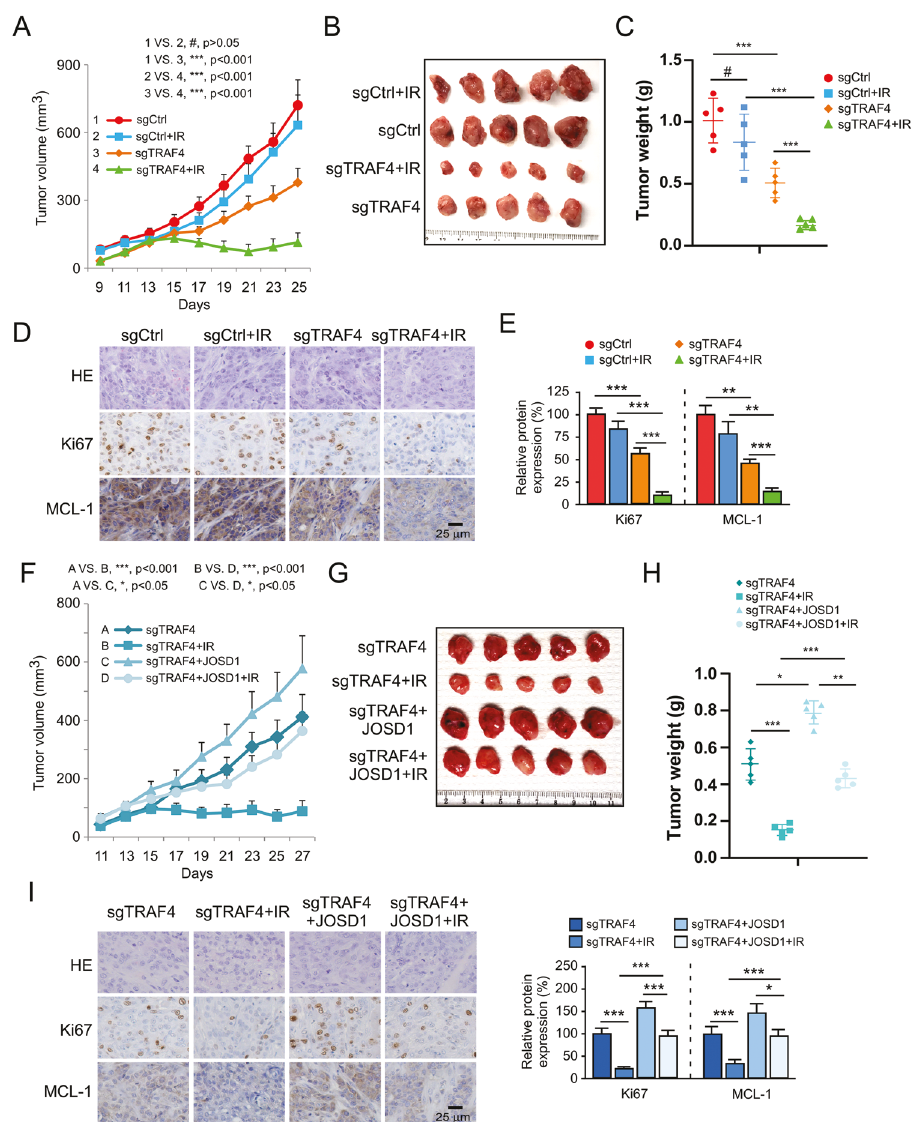
Fig. 6 TRAF4 knockout overcomes radioresistance in vivo. A – E TRAF4 knockout sensitizes OSCC cells to radiotherapy. Xenograft tumors derived from TRAF4 knockout CAL27R cells were treated with/without IR (2 Gy) for 25 days; n = 5 mice per group. Tumor growth curves ( A ), tumor mass images ( B ), and tumor weight ( C ) were recorded. Tumor sections were subjected to IHC staining of Ki67 and MCL-1 ( D ), and quali fi cation analysis of Ki67 and MCL-1 protein expression ( E ). Scale bar, 25 μ m. F – I JOSD1 introduction into TRAF4 knockout CAL27R cells rescues tumorigenesis under IR treatment. Xenograft tumors derived from TRAF4 knockout and ectopic expression JOSD1 CAL27R cells were treated with/without IR (2 Gy) for 27 days; n = 5 mice per group. Tumor growth curves ( F ), tumor mass images ( G ), and tumor weight ( H ) were recorded. Tumor sections were subjected to IHC staining of Ki67 and MCL-1 (I, left), and quali fi cation analysis of Ki67 and MCL-1 protein expression (I, right). Scale bar, 25 μ m. All data are means ± s.e.m. * p < 0.05, ** p < 0.01, *** p < 0.001, a signi fi cant difference between groups as depletion of RPL36A sensitized OSCC cells to DNA damage and promoted G 2 /M cell cycle arrest to upregulate IR-induced apoptosis, which led to increased radiosensitivity in OSCC cells [23]. MicroRNA-125b was reported to be downregulated in OSCC cells, and exhibited an antitumor effect by reducing cell proliferation and enhancing radiosensitivity through the regula- tion of intercellular adhesion molecule-2 signaling [36]. There- fore, further studies on biomarkers and the molecular pathways that are involved in radiation resistance is of great importance to better understand radioresistance characteristics and to formu- late effective treatment strategies to improve the overall survival indicating that intrinsic apoptosis was responsible for blocking of patients with OSCC undergoing radiotherapy. The present TRAF4 to recover the sensitivity of radioresistant OSCC cells to study fi rst determined that TRAF4 was overexpressed in